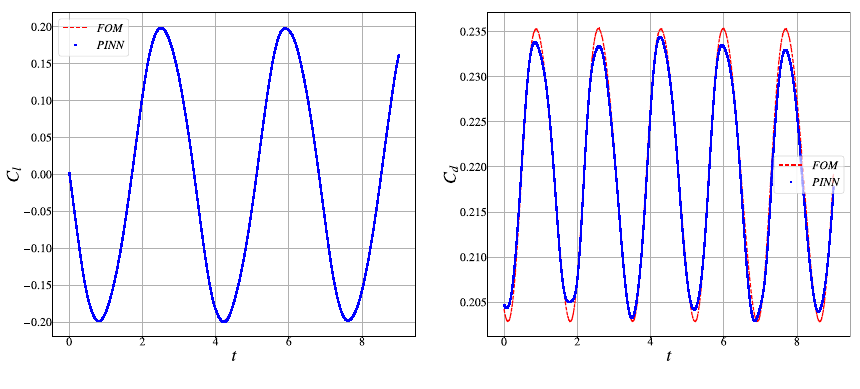
Fig. 8 The lift and drag coefficients curve for the unknown input data ( N u = N p = N S =